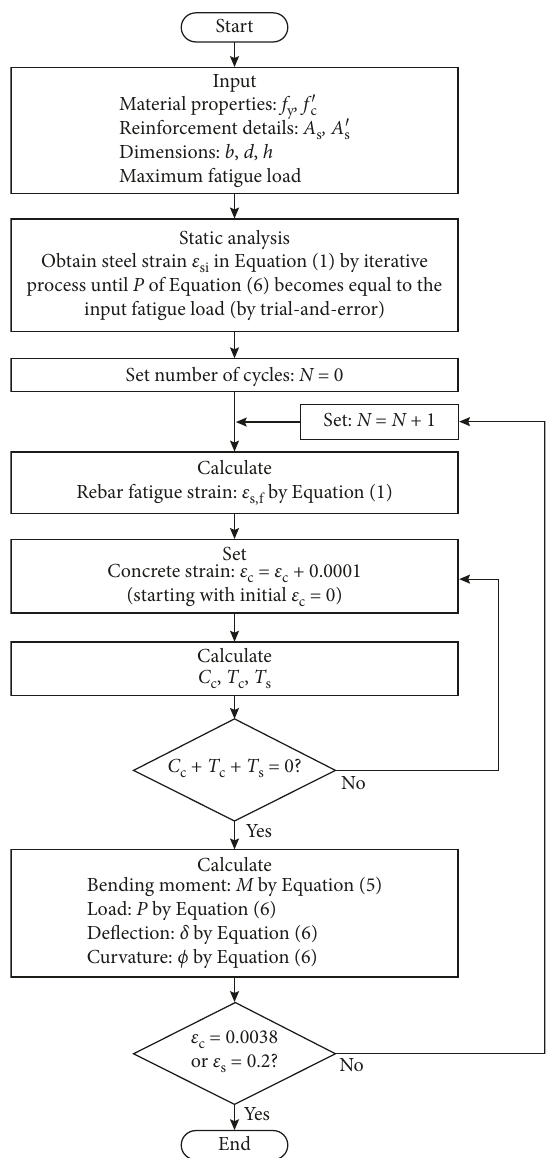
Figure 12: Flowchart of fatigue analysis for nonlinear flexural behavior of the RC